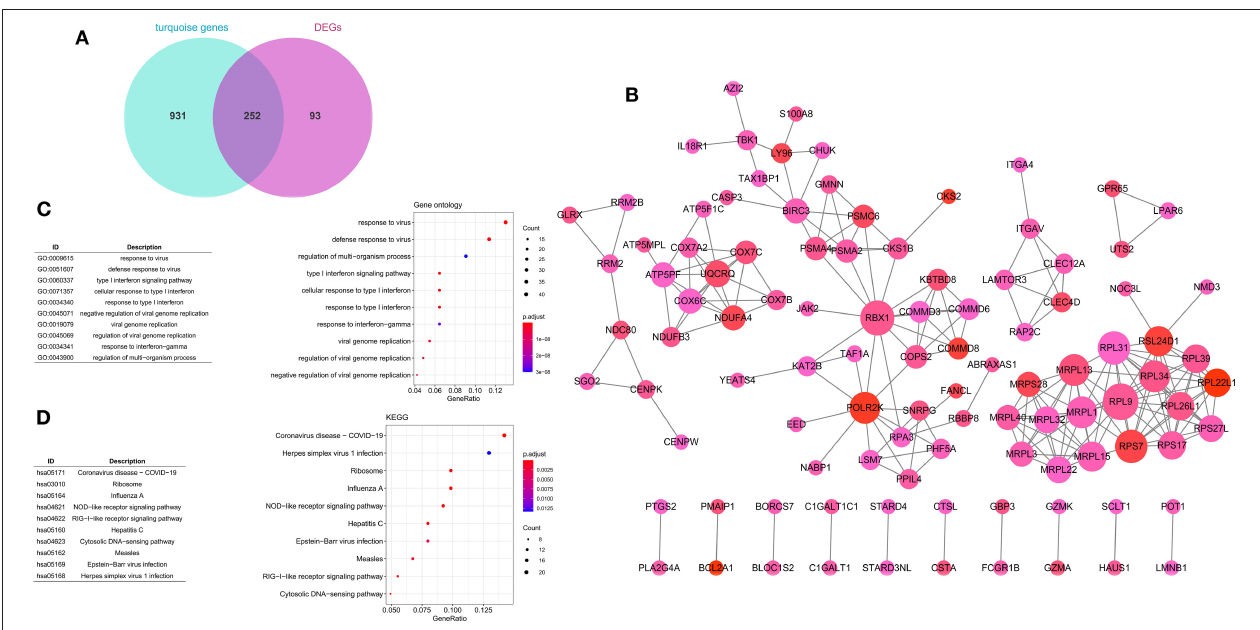
FIGURE 4 | Construction of protein–protein interaction (PPI) network. (A) Venn diagram of key genes. (B) PPI network of key genes. The large nodes have a higher degree, and red nodes have a large log FC. The Gene Ontology (GO) (C) and Kyoto Encyclopedia of Genes and Genomes (KEGG) (D) pathway enrichment analyses of key genes. Circle colors represent P -values as indicated. The circle size represents the GeneRatio, which is the ratio of the number of genes enriched in a certain pathway to the number of genes in the